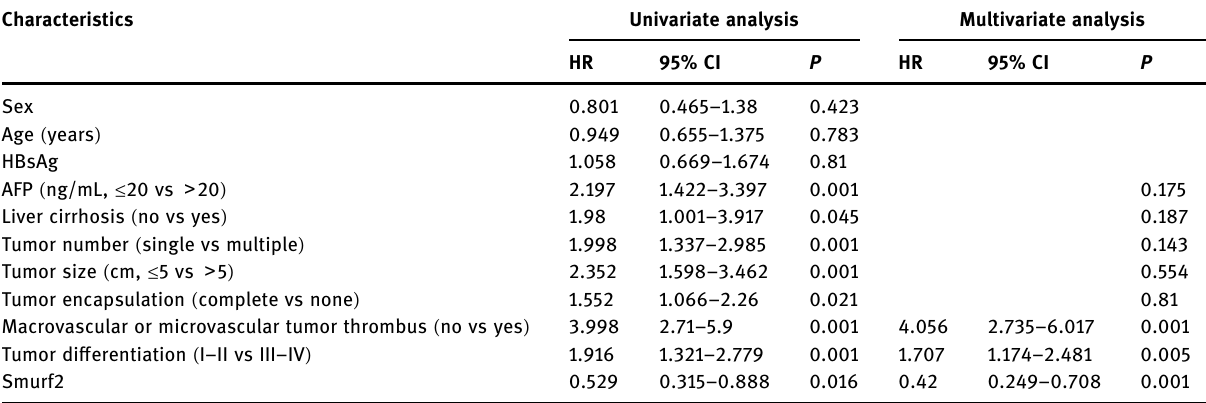
Table 2: Univariate and multivariate analyses of clinicopathological factors for OS in HCC patients Characteristics